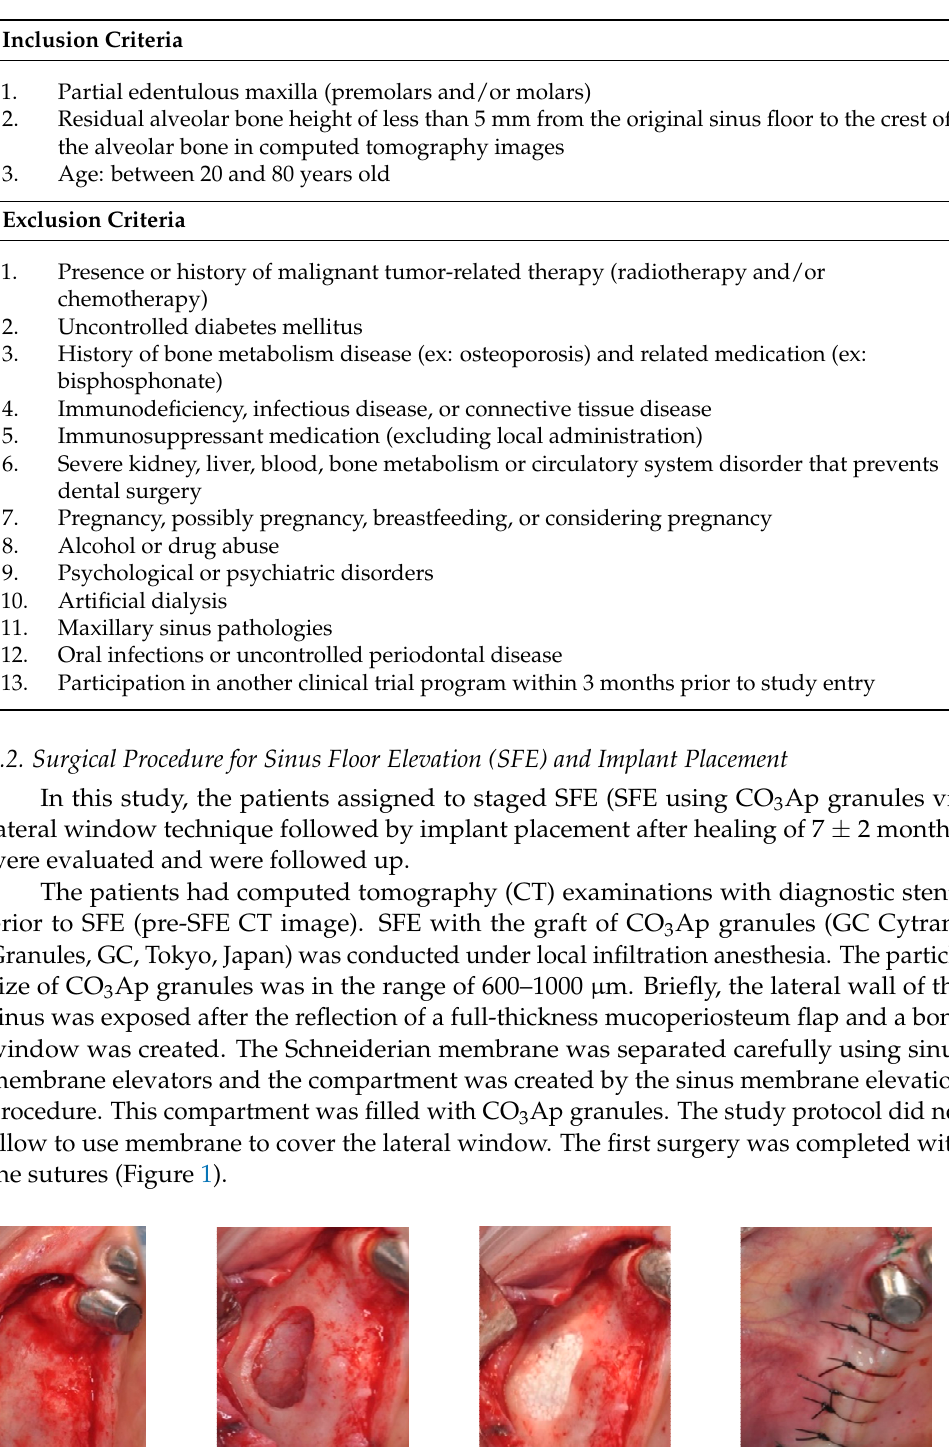
Table 1. Inclusion and exclusion criteria.